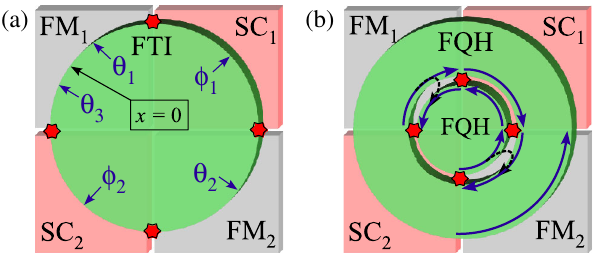
FIG. 1. Schematic setup. (a) A fractional topological insulator (FTI) realization of the system we consider. A FTI droplet with an odd filling factor 1 =m is proximity coupled to ferromagnets (FM) and to superconductors (SC), which gap out its edge modes. The interfaces between the SC and FM segments on the edge of the FTI are marked by red stars. (b) A fractional quantum Hall (FQH) realization of the system we consider. A FQH droplet with filling factor 1 =m is separated by a thin barrier into two pieces: an inner disk and an outer annulus. On either side of the barrier, there are counterpropagating edge states, which are proximity coupled to superconductors and